Question: According to this chart, does the measure grow or shrink?
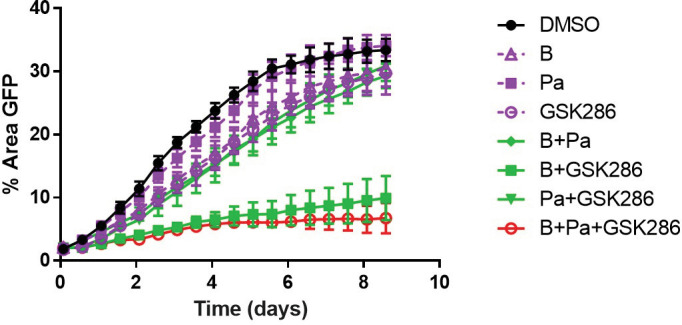
Answer: increasing